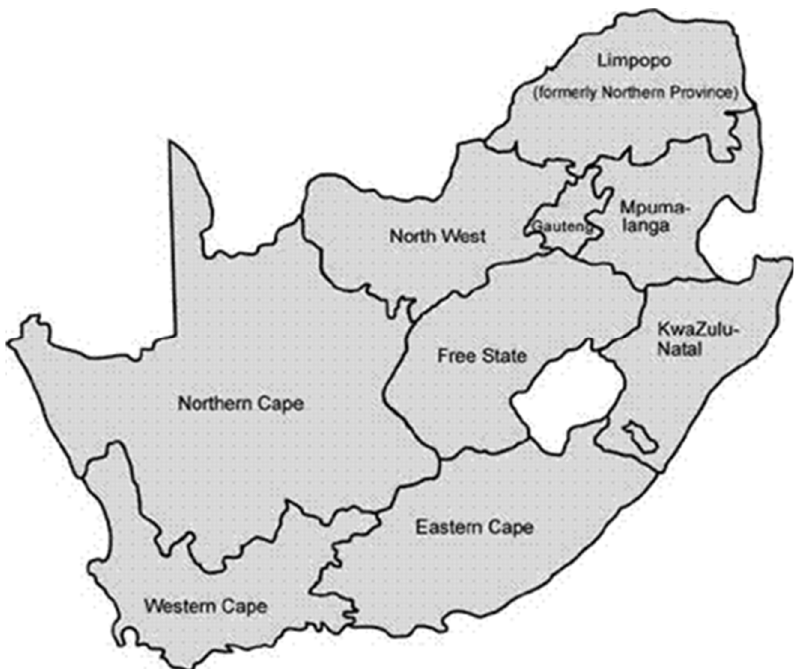
Figure 1. Map of South Africa showing provinces.